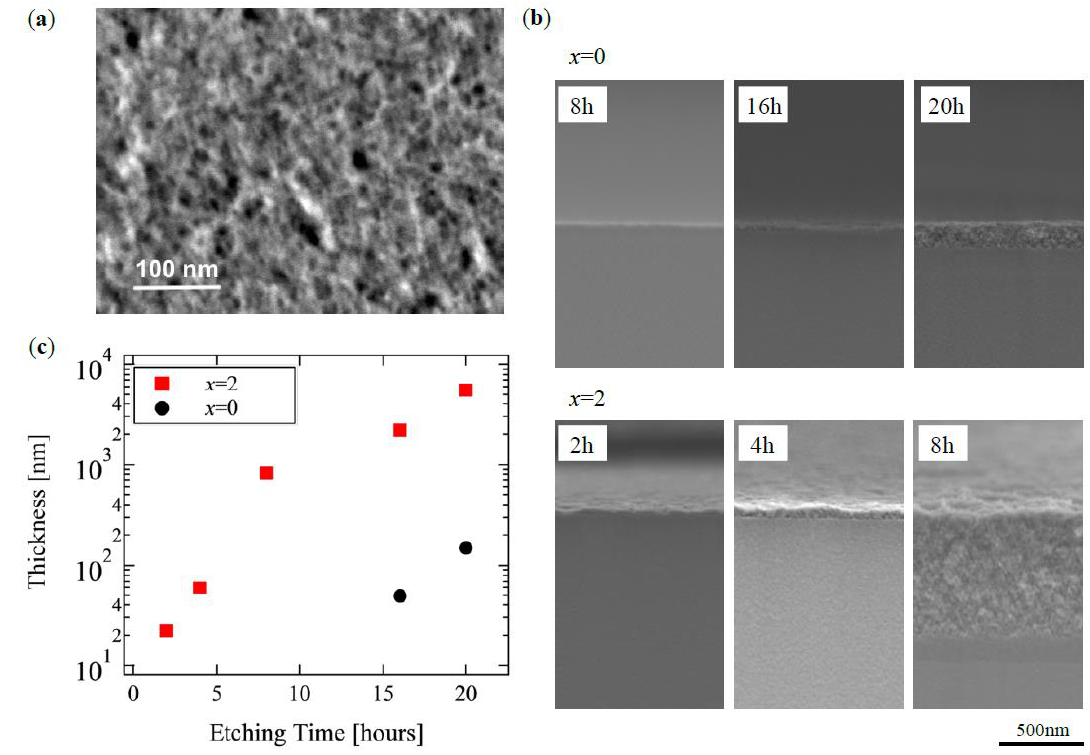
Figure 2. Scanning electron microscope (SEM) micrographs of ( a ) surface of x = 2 sample after 16 h treatment and ( b ) cross-section of both chemical composition of glass (x = 0.0, 2.0). The hierarchical nanoporous layer (HNL) thickness is shown in ( c ) as a function of the etching time.